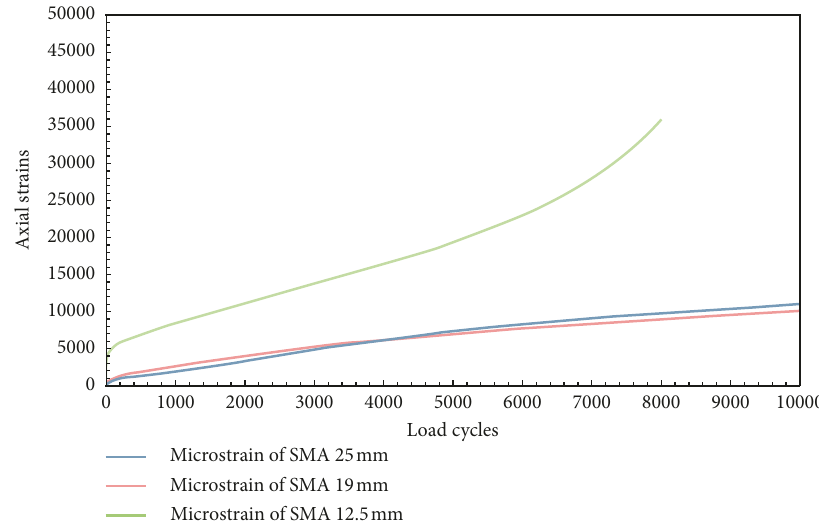
Figure 6: Load cycles versus axial